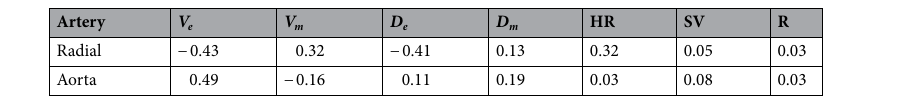
Table 4. Correlation between parameters and time lags from different